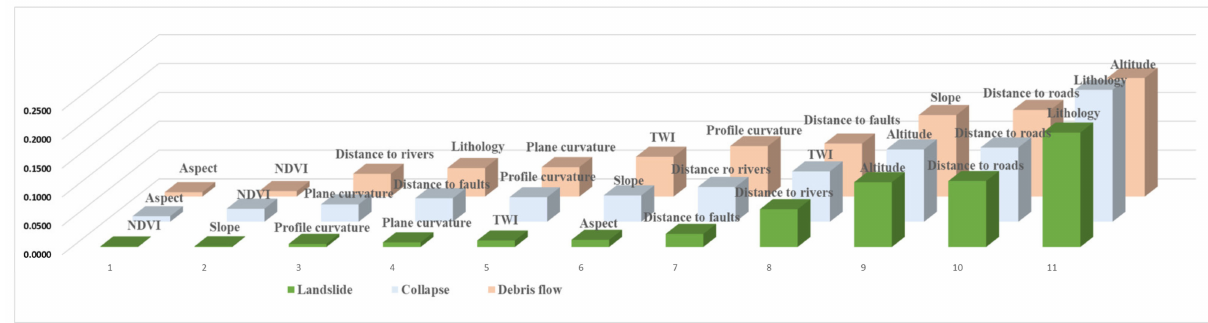
Figure 5. The information gain ratios of the conditioning factors for collapse, landslide, and debris